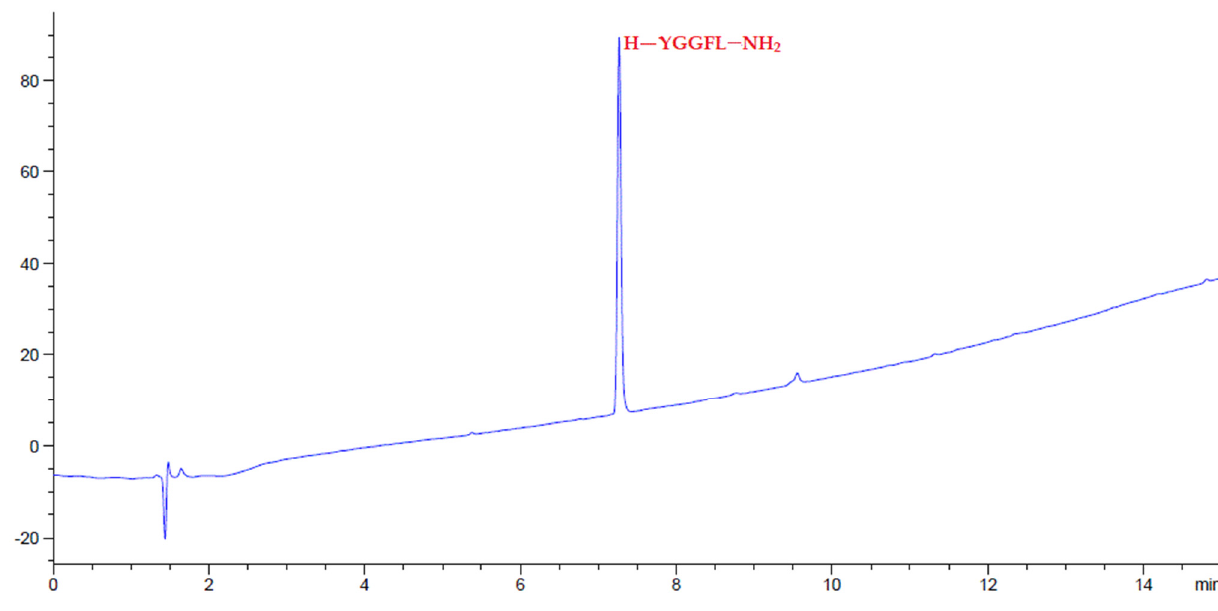
Figure 6. HPLC chromatograms of crude peptides H-YGGFL-NH 2 after precipitation.